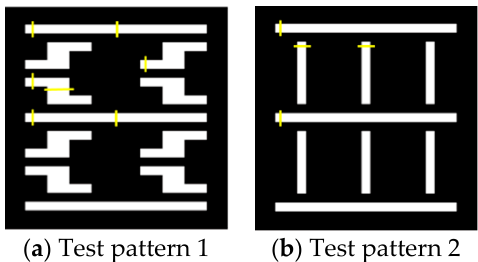
Figure 2. Two test patterns used in the simulation: ( a ) Test pattern 1; ( b ) Test pattern 2. The PW calculation positions are marked at the yellow